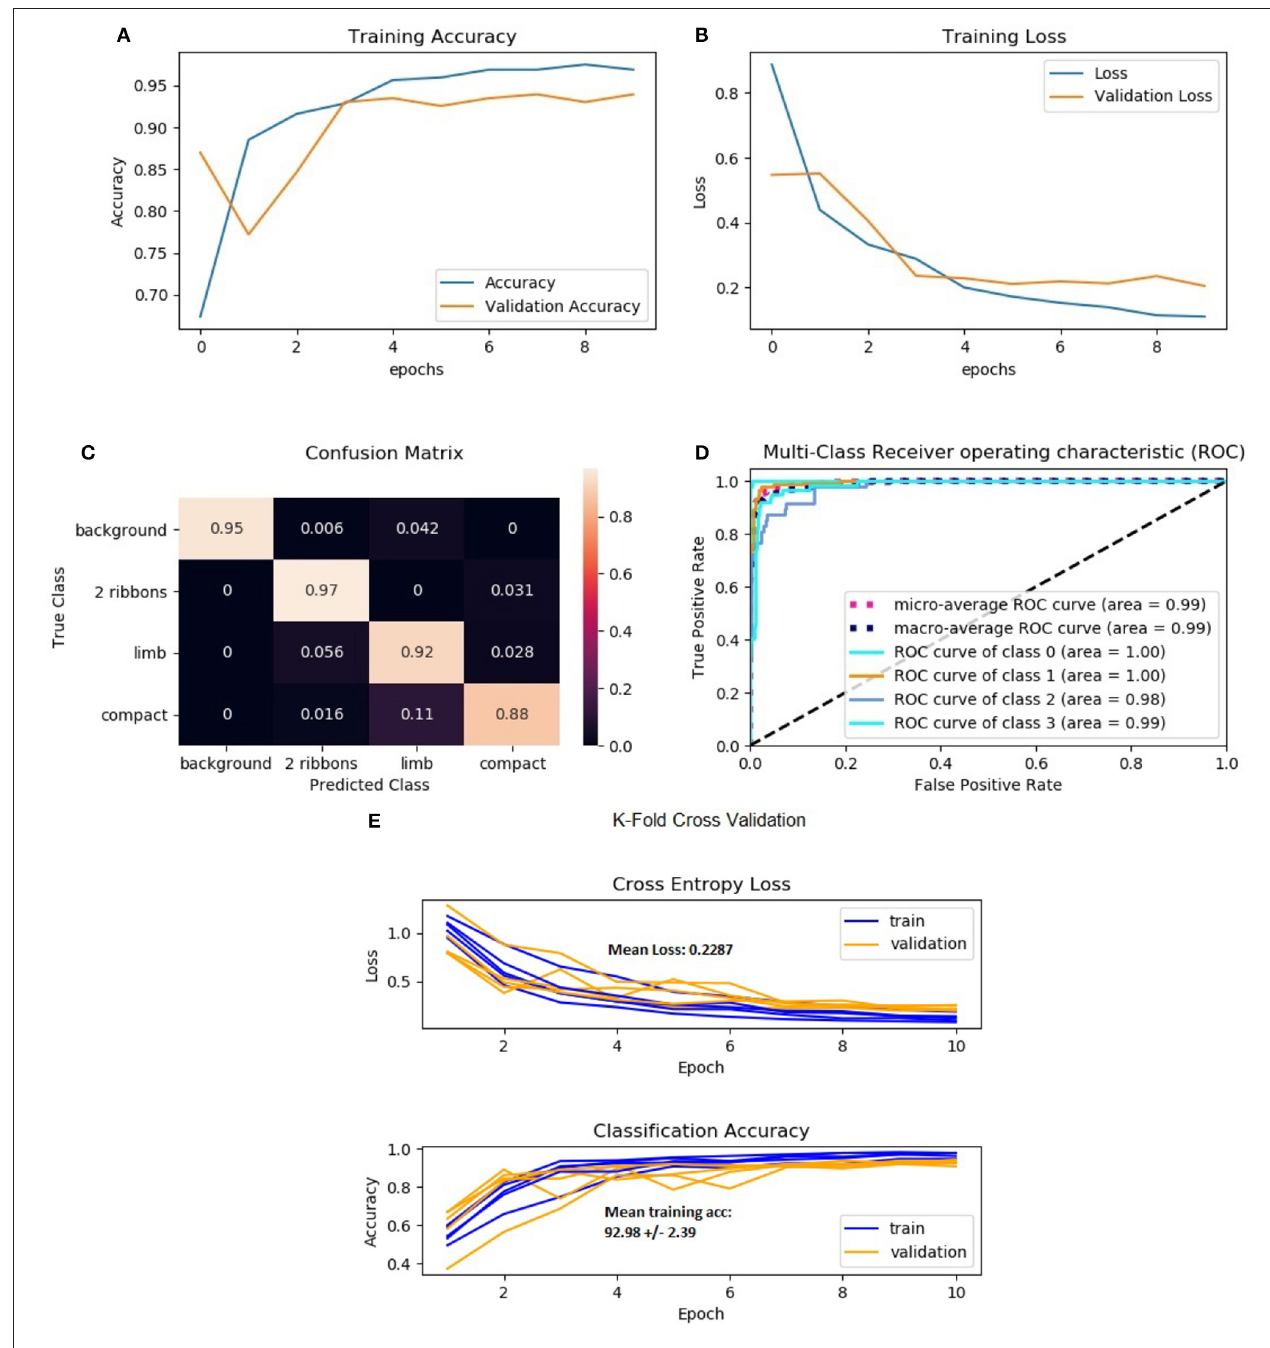
FIGURE 2 | (A) Training accuracies with both validation and training accuracies shown over 10 epochs; (B) Training and validation loss shown over 10 epochs; panel (C) shows the confusion matrix created on the test set, with the diagonal showing the correctly identified ribbon types; panel (D) shows the receiver operating characteristic (ROC) curve which has been modified to include a curve for each class and the micro and macro average curves; panel (E) shows the results for loss and accuracy whilst using k-fold cross validation, where k = 5.